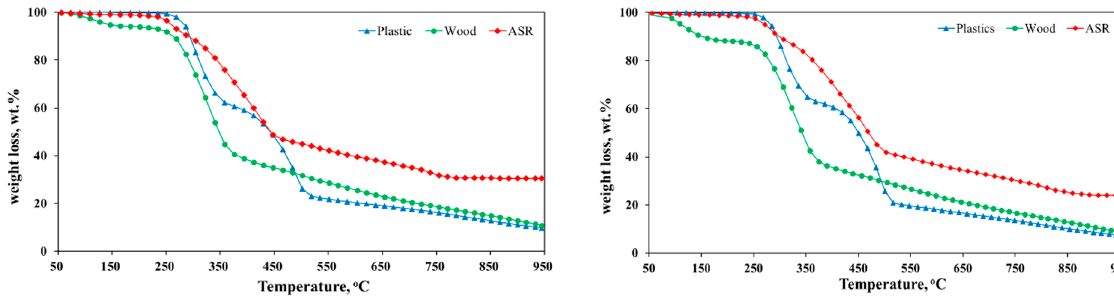
Figure 4. TGA Results of Fuels .